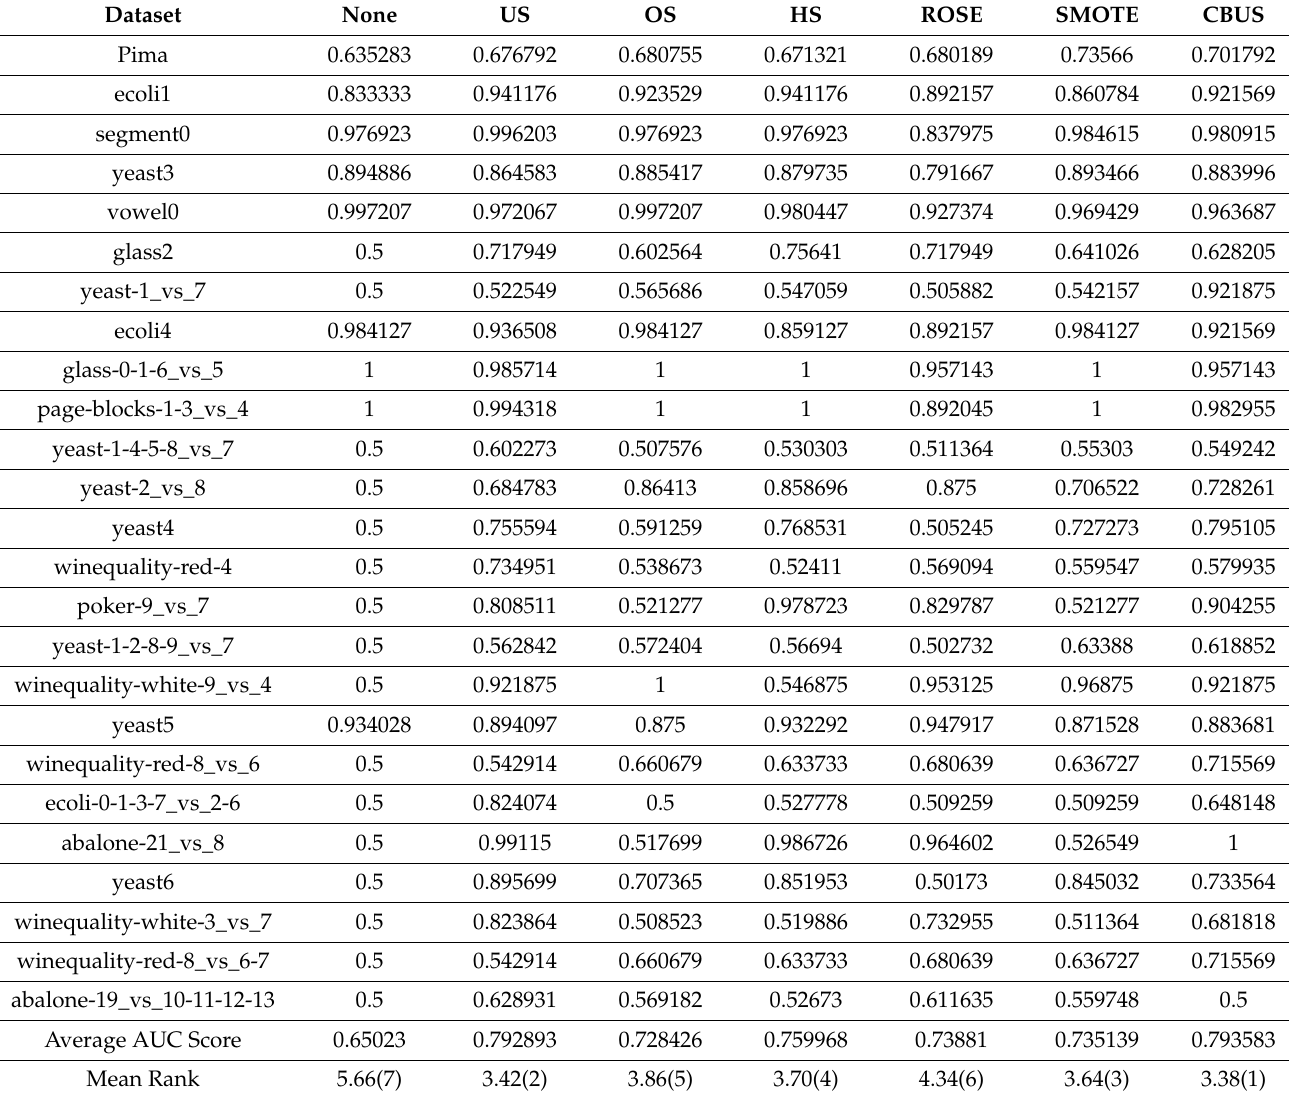
Table 2. Performance of DBT for DT